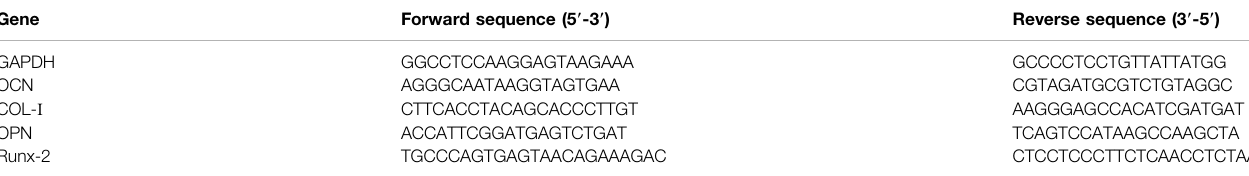
TABLE 1 | Osteogenic primer sequences for